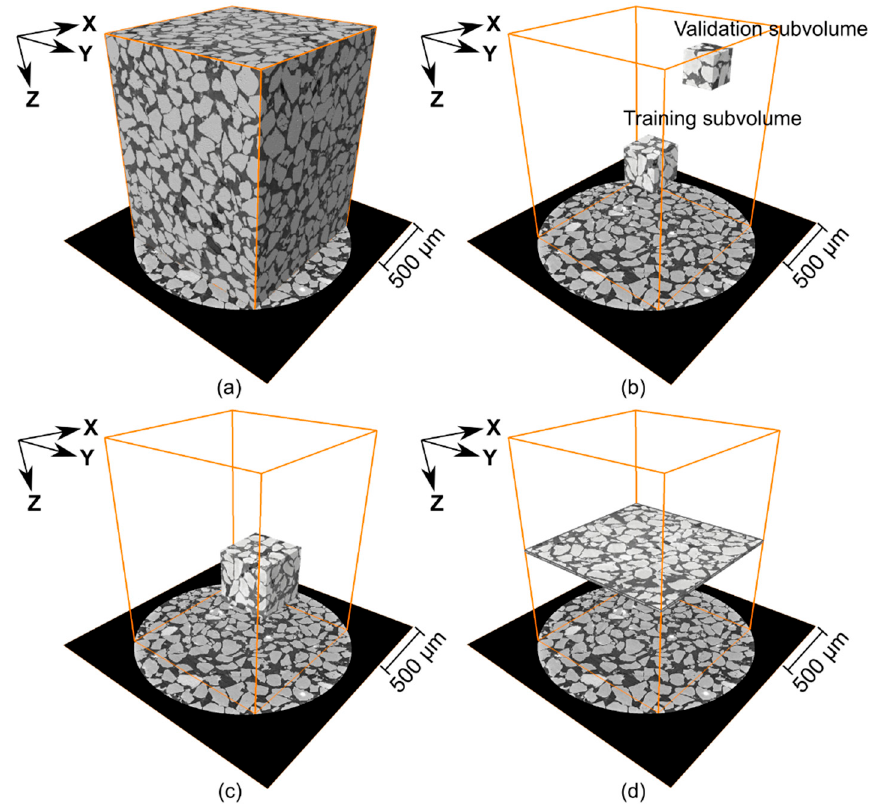
Figure 4. For dataset IC01: ( a ) analysis region used for U-Net segmentation; ( b ) location of 3D training and 3D validation subvolumes; ( c ) location of 2D learning subvolume; ( d ) quantitative analysis slices.